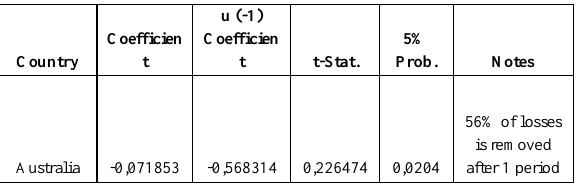
Error Correction